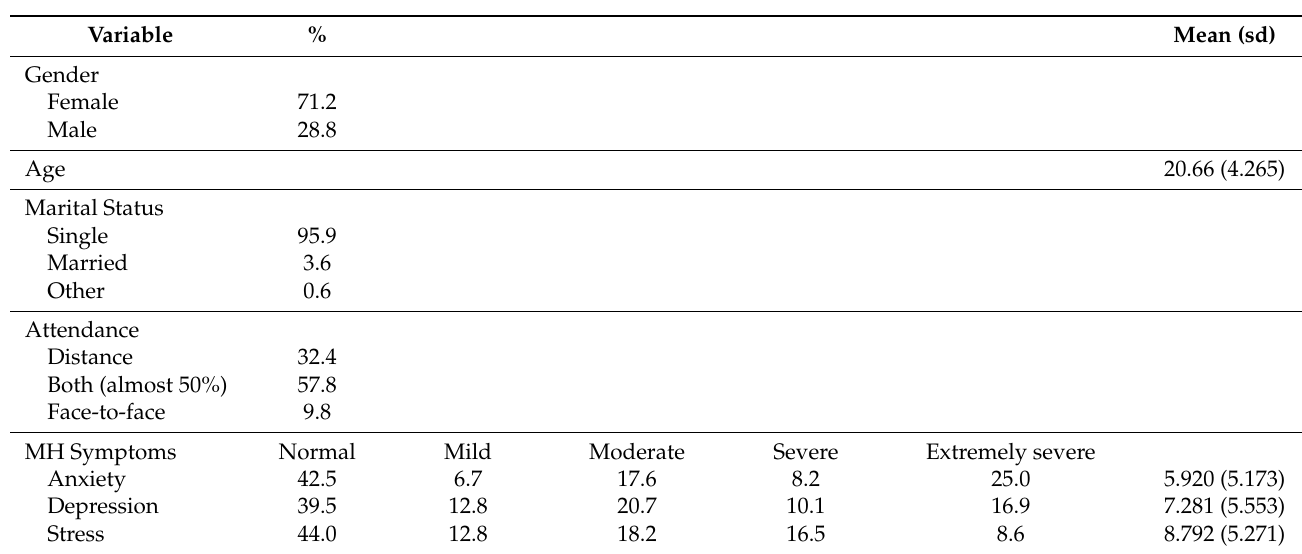
Table 1. Sample demographic and mental health symptoms